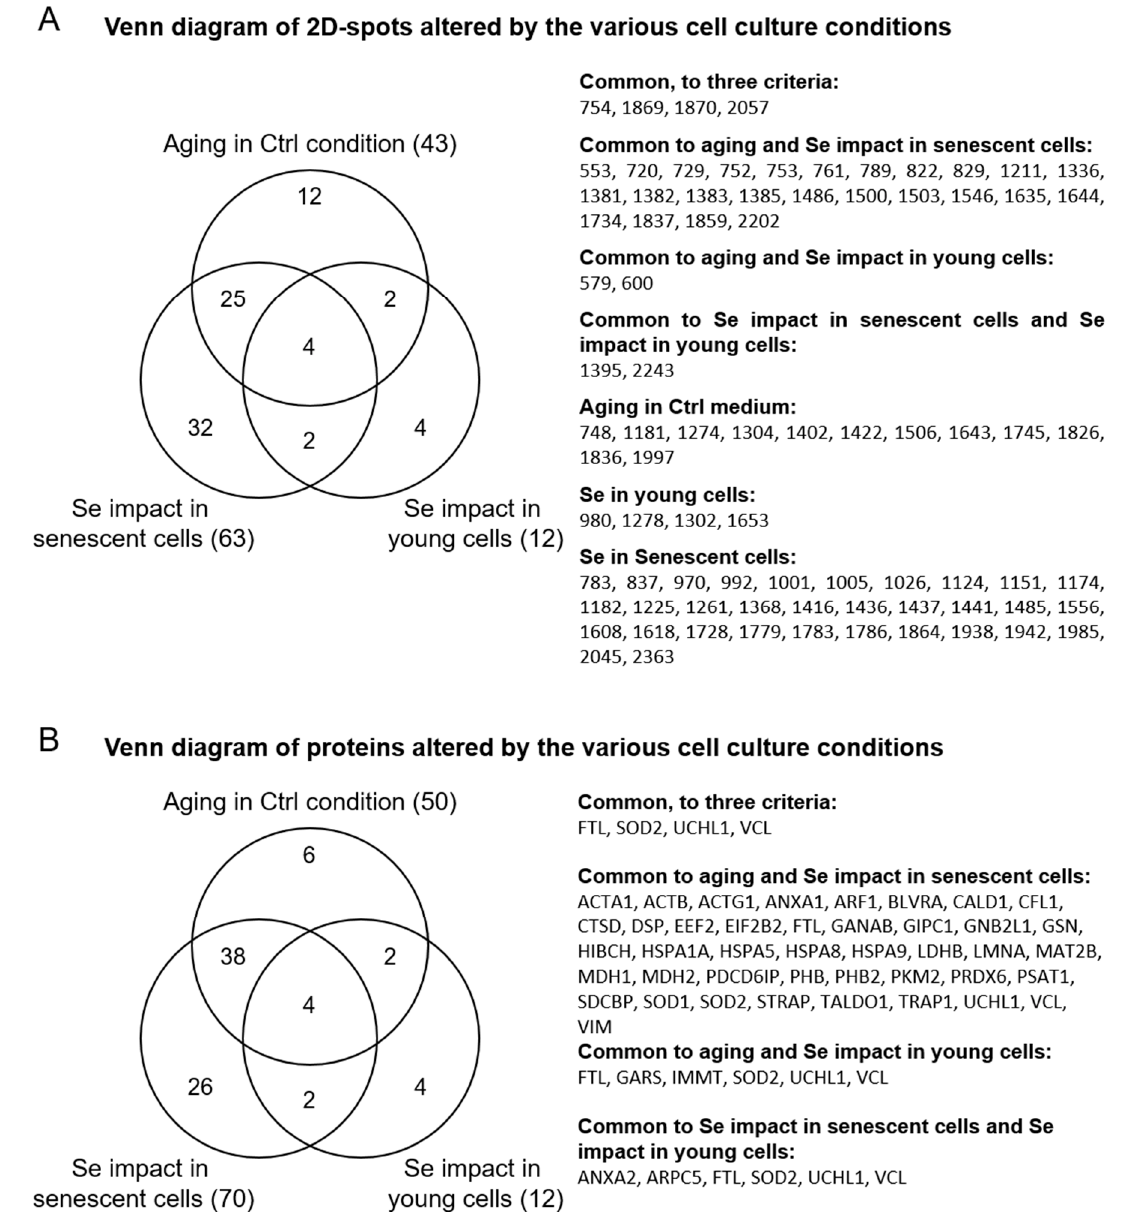
Figure 6. Figure 6. Venn diagram analyses for the differentially expressed spots ( A ) and identified proteins ( B ) in response to senescence and/or selenium level variation in young or senescent